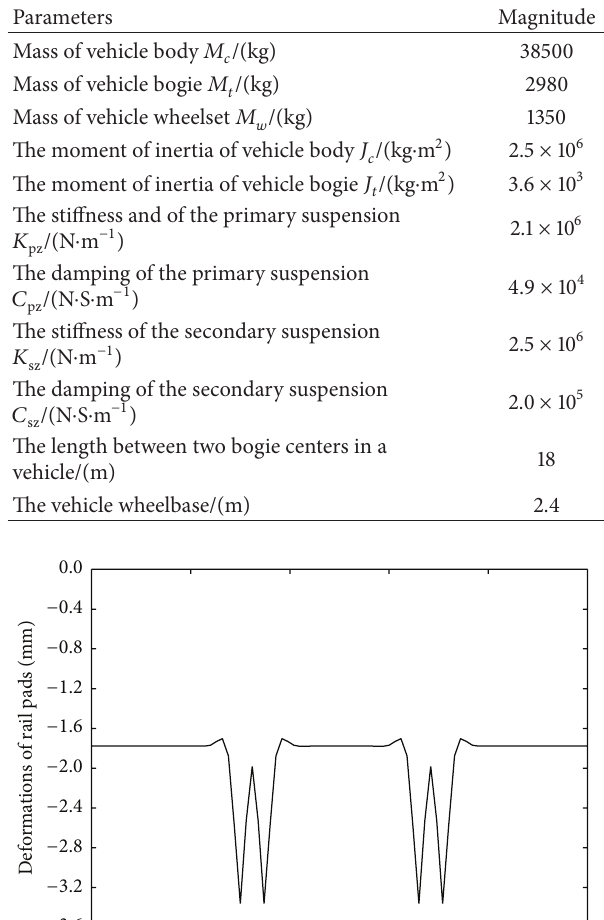
Table 1: The parameters of Chinese “Type A” subway vehicle.